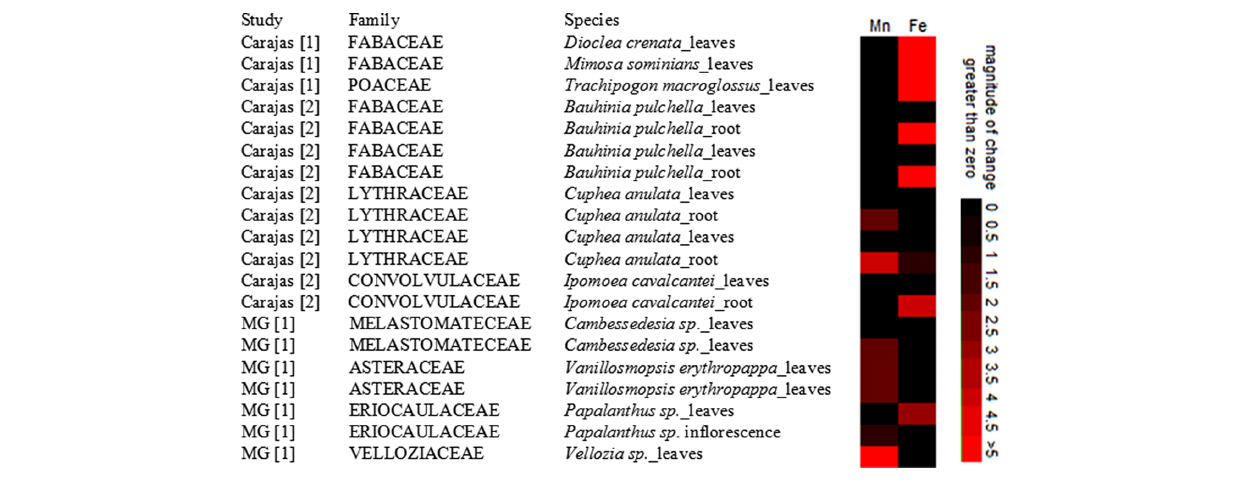
FIGURE 2 | Canga plant species accumulating at least double the standard concentration of manganese (200 ppm) and iron (300 pm). From Porto and da Silva (1989) and Silva (1992).Two entries given to one specie indicate populations collected in different area of occurrence.